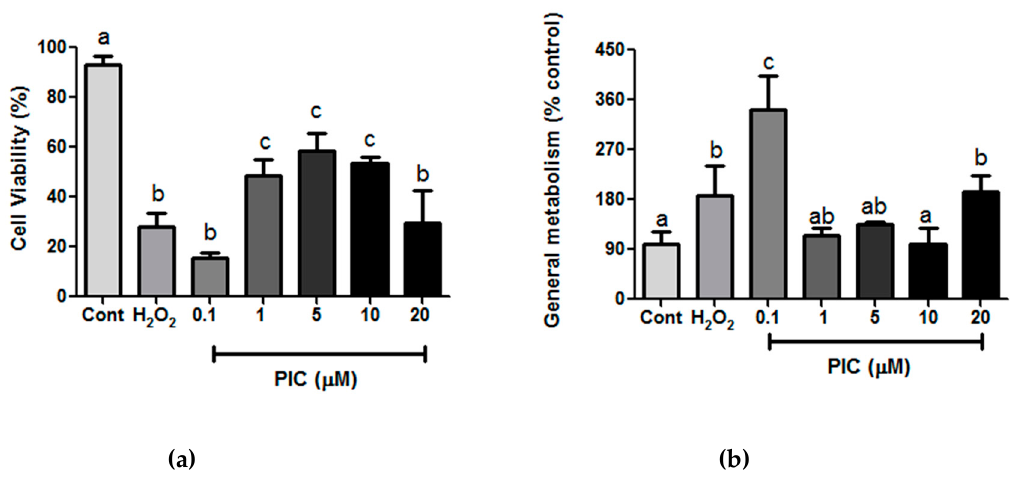
Figure 3. ( a ) Cell viability and ( b ) general metabolism status after 1-h treatment with hydrogen peroxide (H 2 O 2 ) (200 μ M) and different concentrations of piceatannol (Pic); Cont: control. The results are expressed as mean ± SD. Statistical differences between treatments at the same analysis were shown by lower case (a–c) on graph ( p ≤ 0.05).